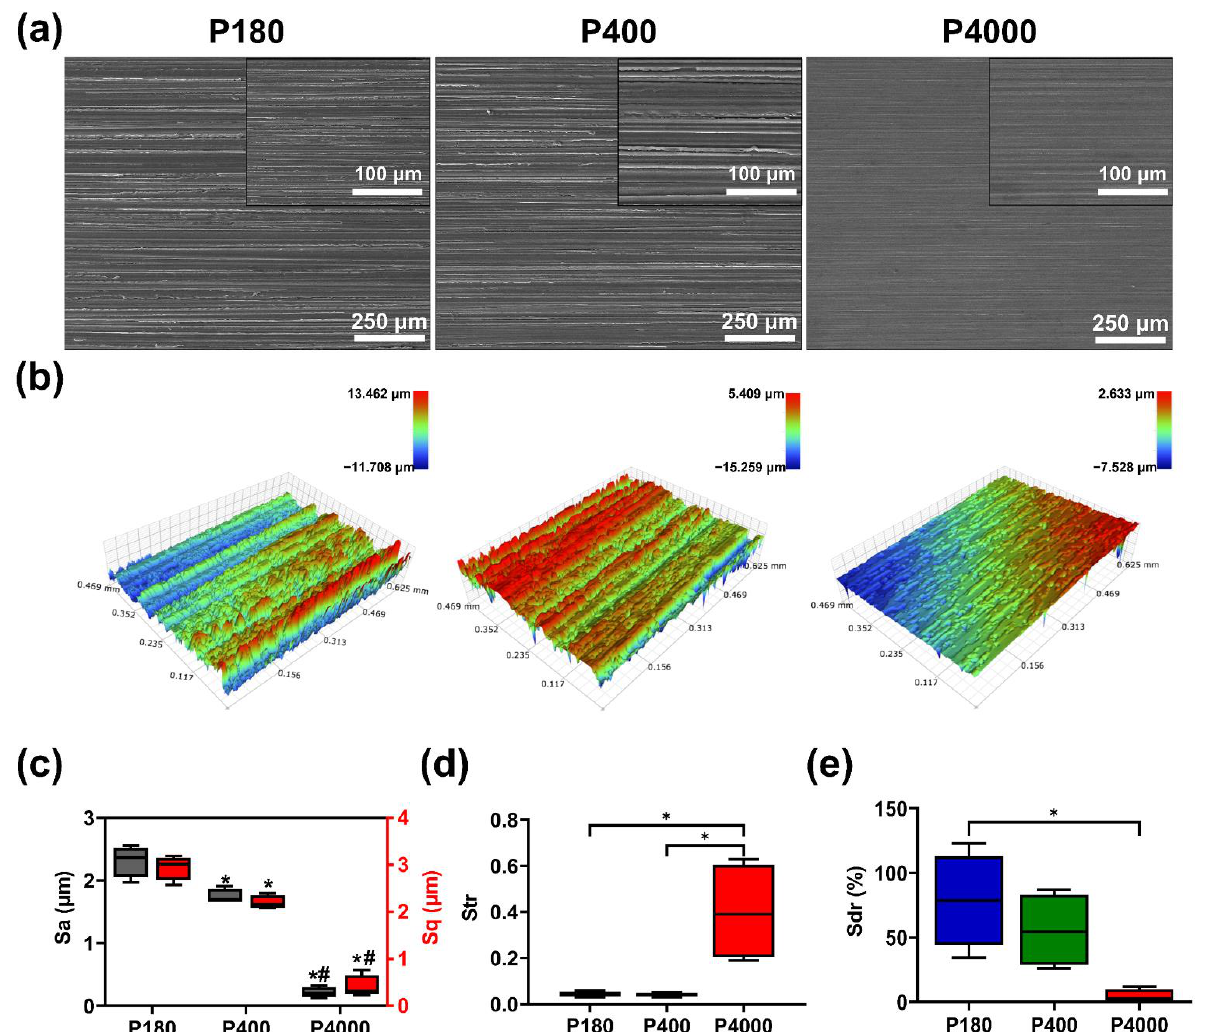
Figure 1. Surface morphology and surface roughness of specimens. ( a ) Representative SEM magnification of different specimens (magnification 100 × , scale bar = 250 µ m). The inset images corresponded to the magnified surface morphologies (magnification 500 × , scale bar = 100 µ m). ( b ) Reconstructed three-dimensional surface of specimens with different surface roughness. ( c ) Arithmetical mean height (Sa) and root mean square height (Sq). * and # represent a statistical difference ( p < 0.05) when compared with the P180 and P400, respectively. ( d ) Texture aspect ratio (Str). * represents a statistical difference between the two groups. ( e ) Developed interfacial area ratio (Sdr). * represents a statistical difference between the two groups.